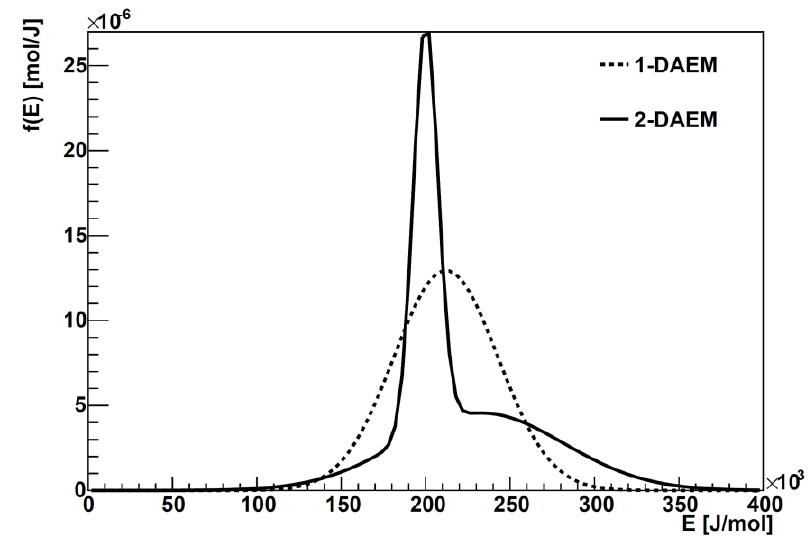
Figure 9. Distribution activation energy curves vs. activation energy for 1-DAEM and 2-DAEM applied to Sulcis coal experimental